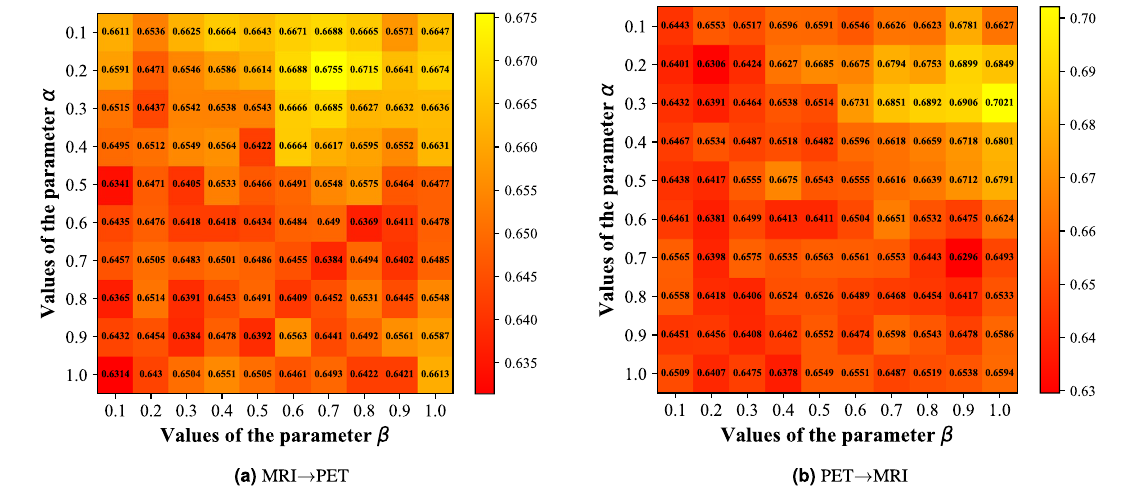
Figure 5. The mAP scores on ADNI2 with hyper-parameters in the range of [0.1, 1].